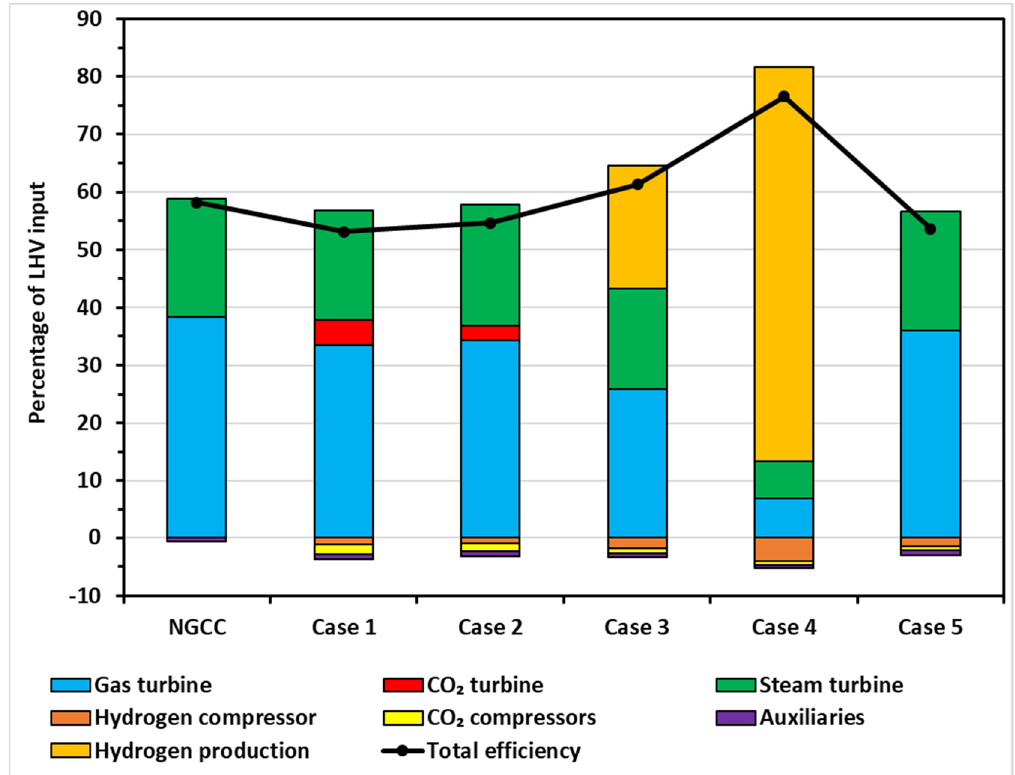
Figure 9. Power breakdown and total efficiency of the different cases.